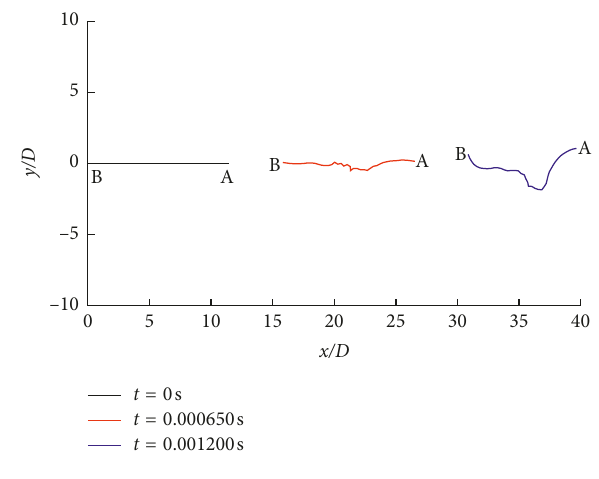
Figure 7: Motion of free fiber in jet flow.